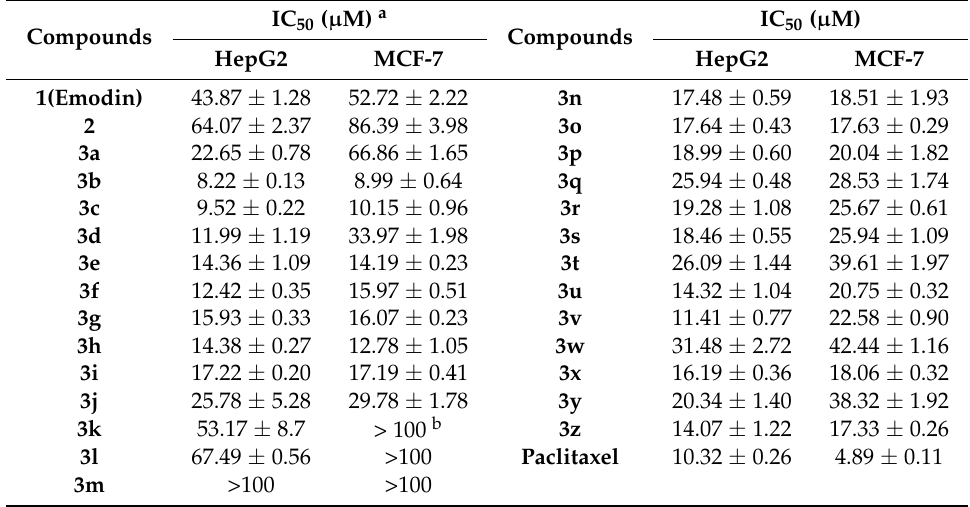
Table 1. Anti-proliferative activities of compounds 3a–3z . Compounds